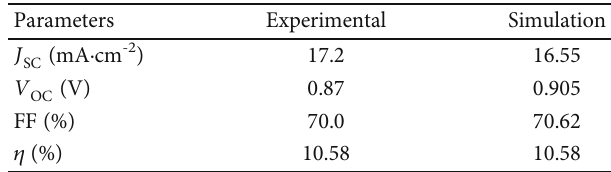
Figure 2: Experimental and simulated J-V characteristics of the a-Si:H-based solar cell. Table 2: Experimental and simulated electrical parameters of the a- Si:H-based solar